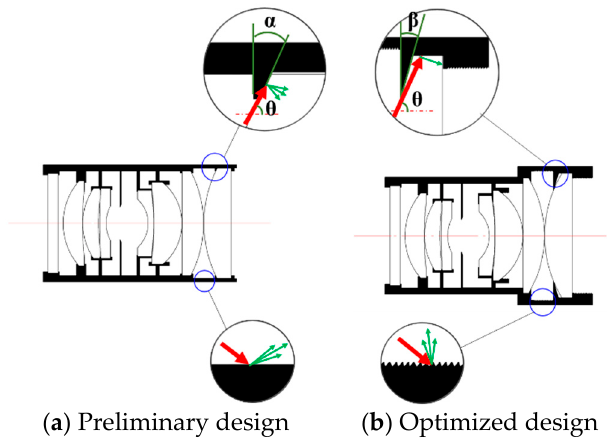
Figure 10. Optimization of lens internal structure.